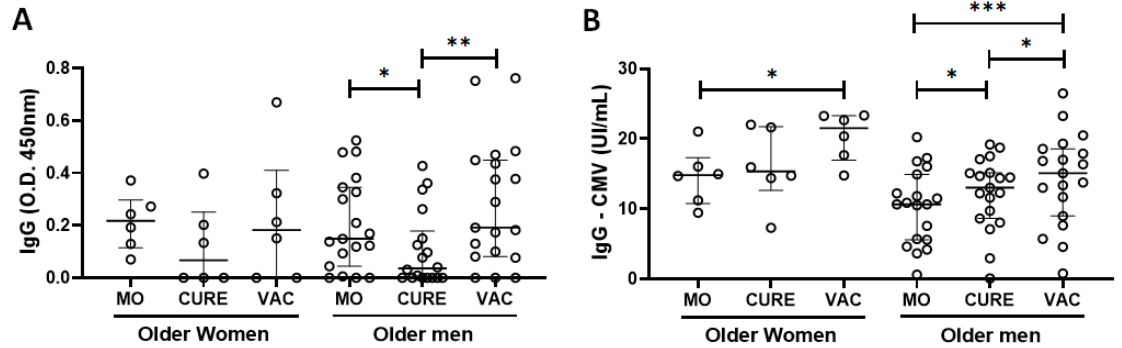
Figure 2. Total serum levels of IgG specific for SARS-CoV-2 (O.D. 450 nm—( A )) and CMV (UI/mL—( B ))